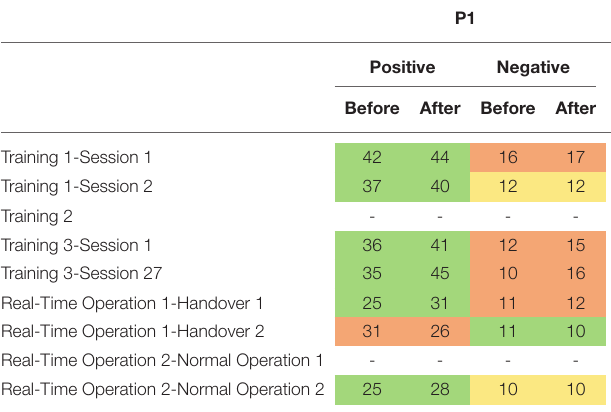
TABLE 2 | Result table of the PANAS questionnaire for P1.